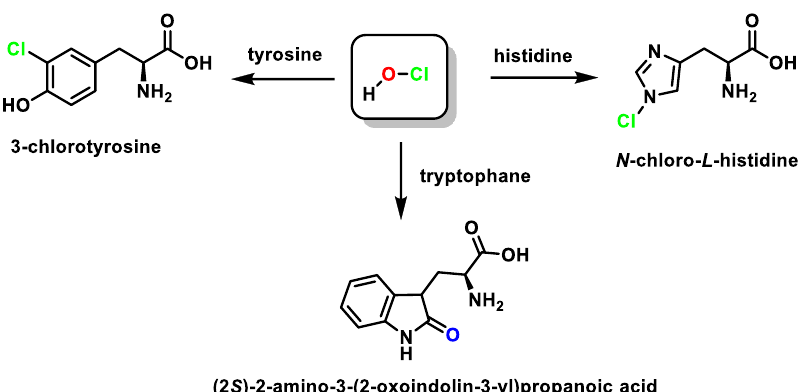
Figure 22. Products obtained in the reaction of aromatic amino acids with HOCl.